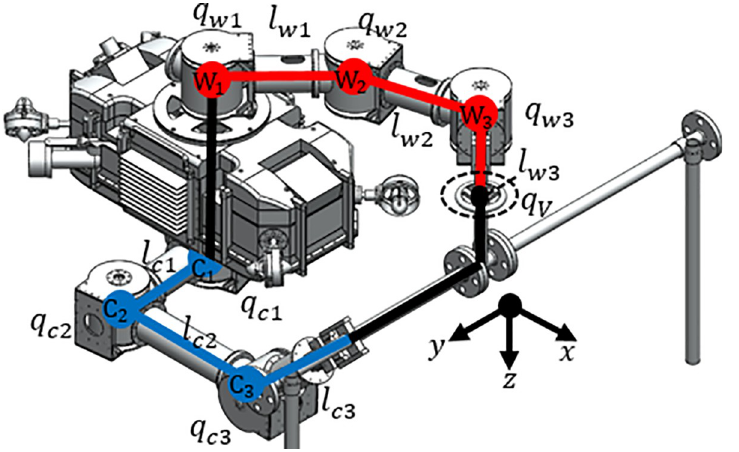
Fig 1. Overall form and kinematic diagram of